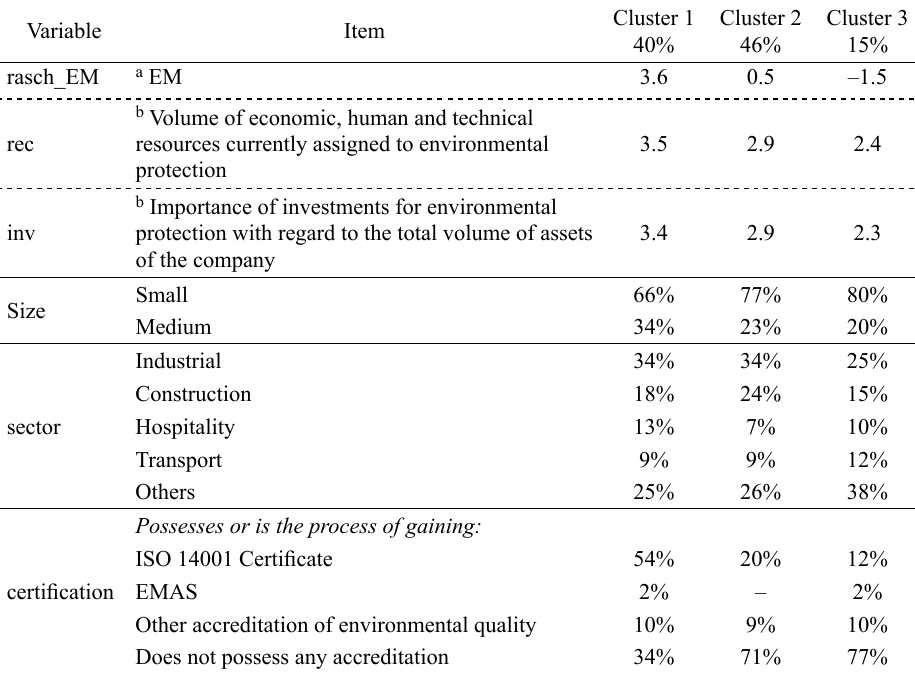
Table 5. Profiles of the variables defining the